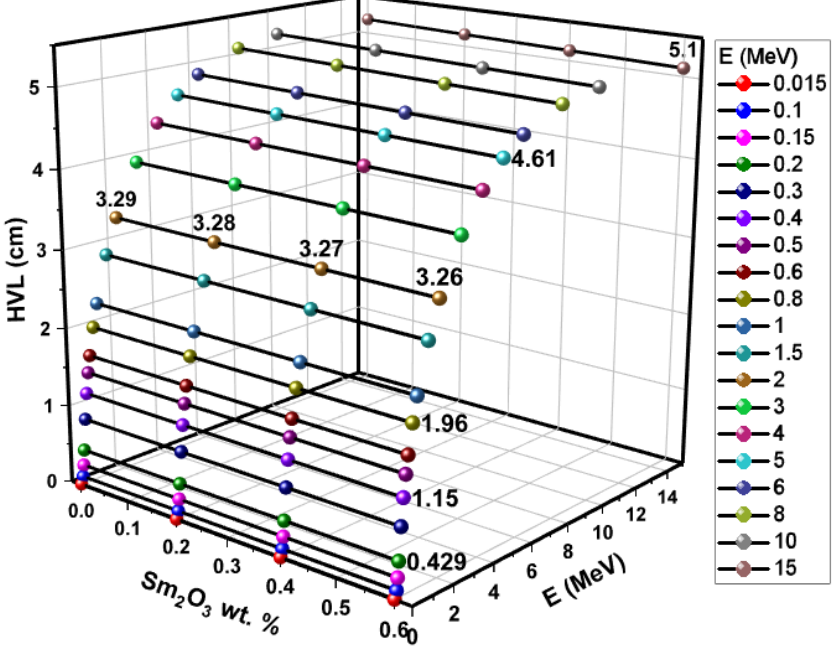
Figure 12. HVL results of glass samples as a function of glass composition and photon energy.